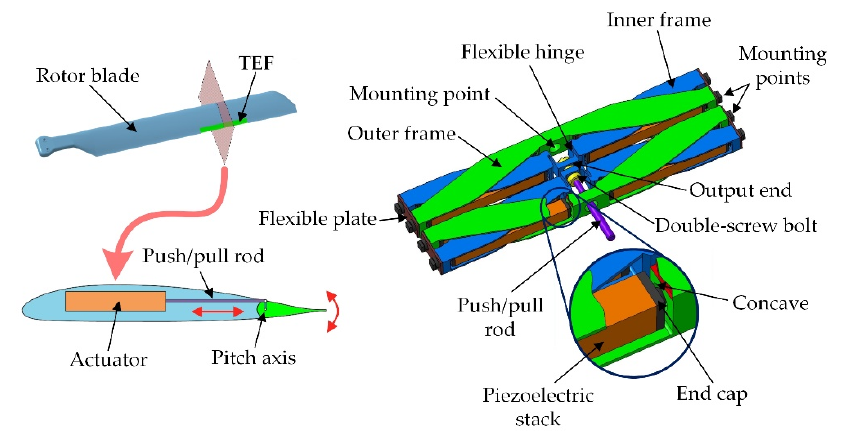
Figure 1. Structure of the double-acting piezoelectric actuator.